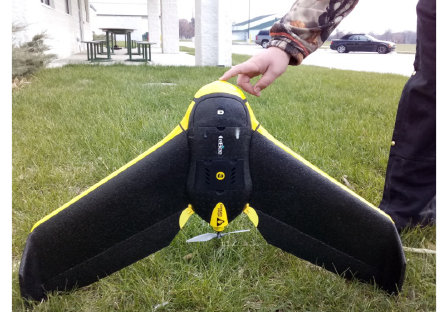
Table 2. Channel specifications of the Parrot Sequoia sensor. Figure 1. UAS platform: senseFly eBee The ground truth data of the location of the tile lines was performed by (Rahmani et Schulze, 2020). Aerial imagery was used to manually locate tile lines based on the spectral differences of wet and dry soil: soil over tile lines dries faster than in between tiles; this causes a higher reflectance in visible and near infrared regions of the electromagnetic spectrum. Next, the tile probe method was carried out to conduct ground validation of the mapped tile lines. Since the diameter cm. After sensing the identification of the tile lines, locations were recorded with real time kinematic